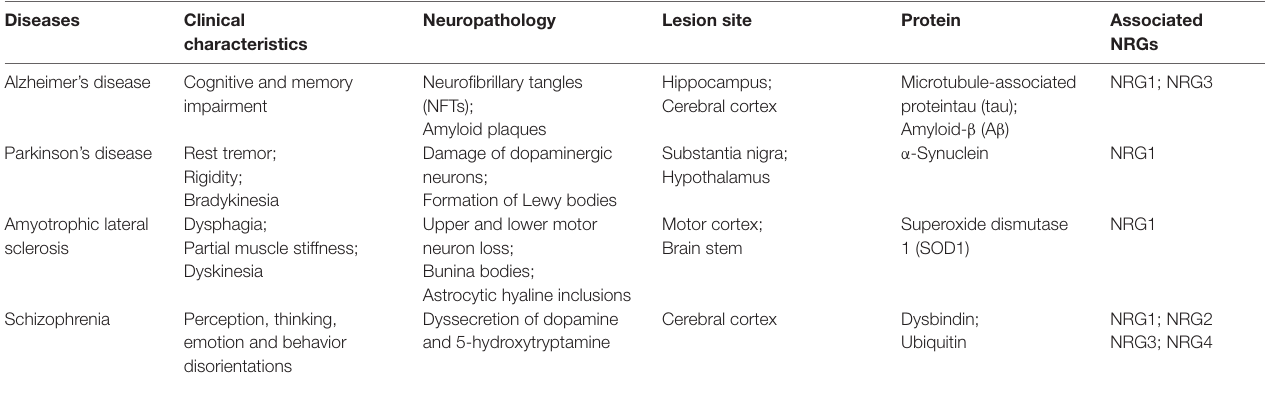
TABLE 4 | Overview of selected neurodegenerative